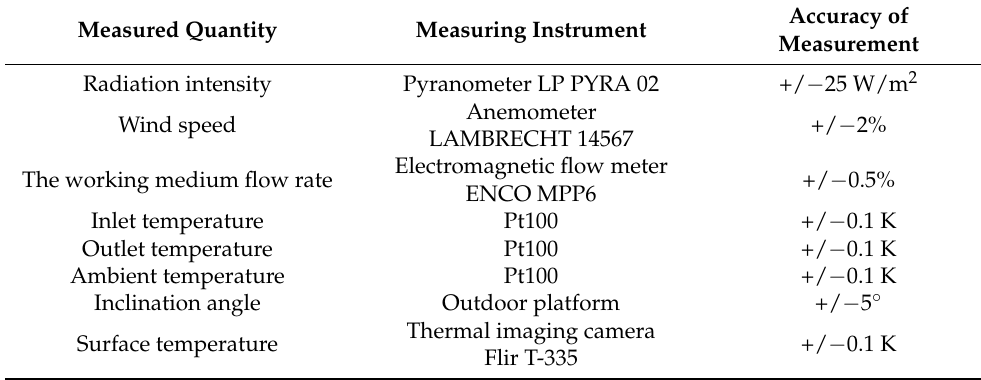
Table 2 . Accuracy of measuring instruments. Table 2. Accuracy of measuring instruments.